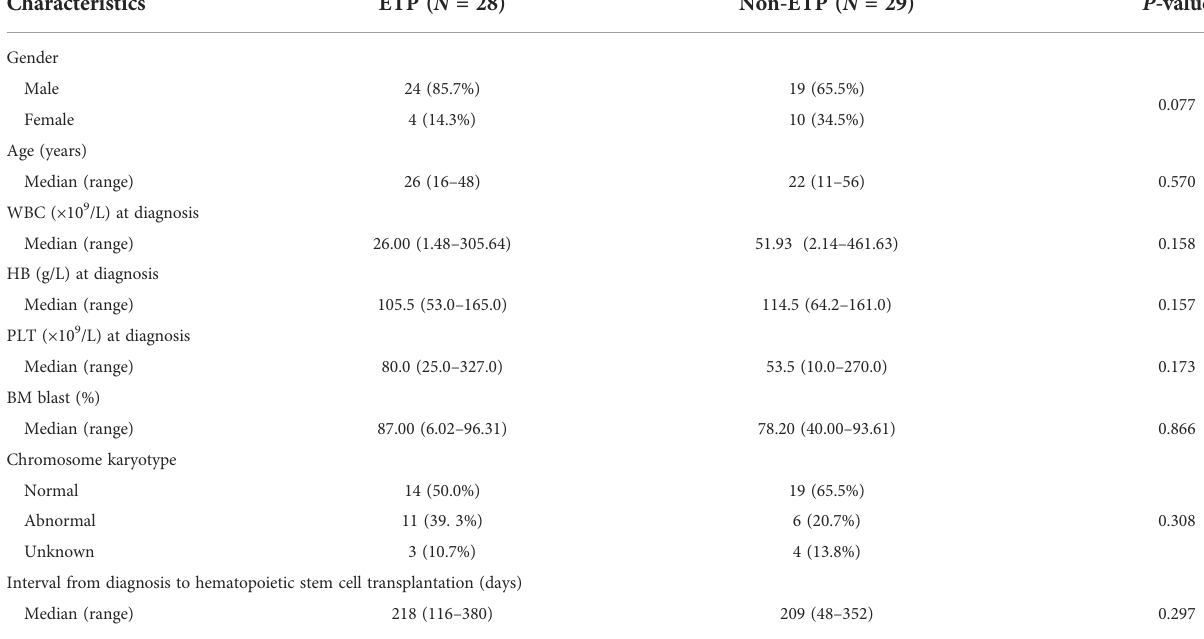
TABLE 1 Characteristics of